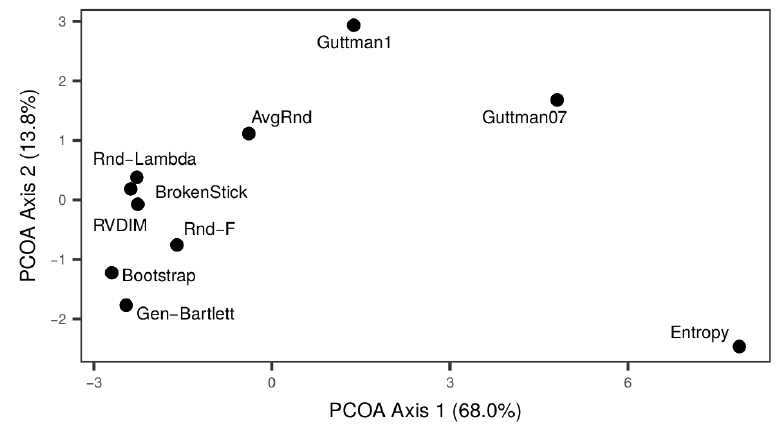
Figure 2. Ordination of the 10 stopping rules based on their performance. Each method was described by a total of 198 descriptors, which corresponded to the power and type-I error using different options for simulated data generation: sample size of 30 units, 11 eigenstructures (see Table 1) and 9 increasing levels of introduced noise (starting from zero). Power was the proportion of simulated data in which the last informative dimension in the specified eigenstructure was detected as relevant by the stopping rule. Type-I error is the proportion in which the first residual dimension was (wrongly) detected as information by the stopping rule. For this graphic, Principal Coordinates Analysis based on Euclidean distances between methods was used. Axes 1 and 2 are accounted for 68.0% and 13.8% of total inertia, respectively. See main text for the description of the stopping